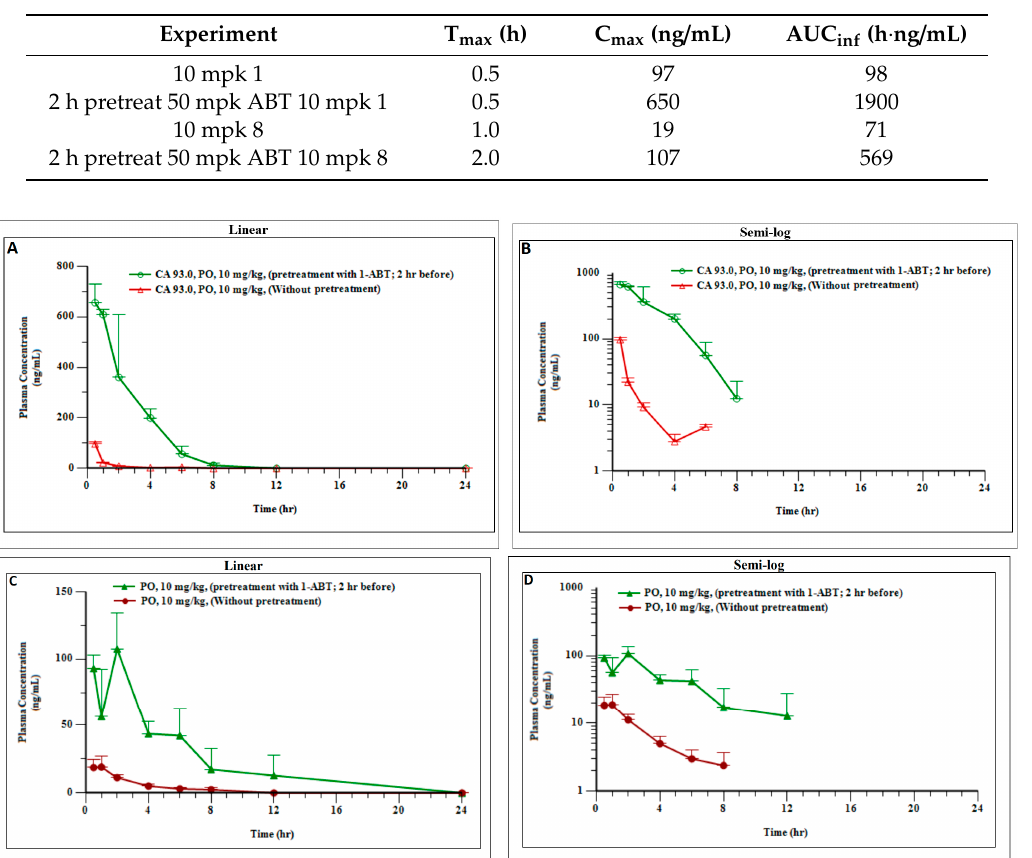
Table 5. Pharmacokinetic profile of 1 and 8 with and without pre-administration of ABT.